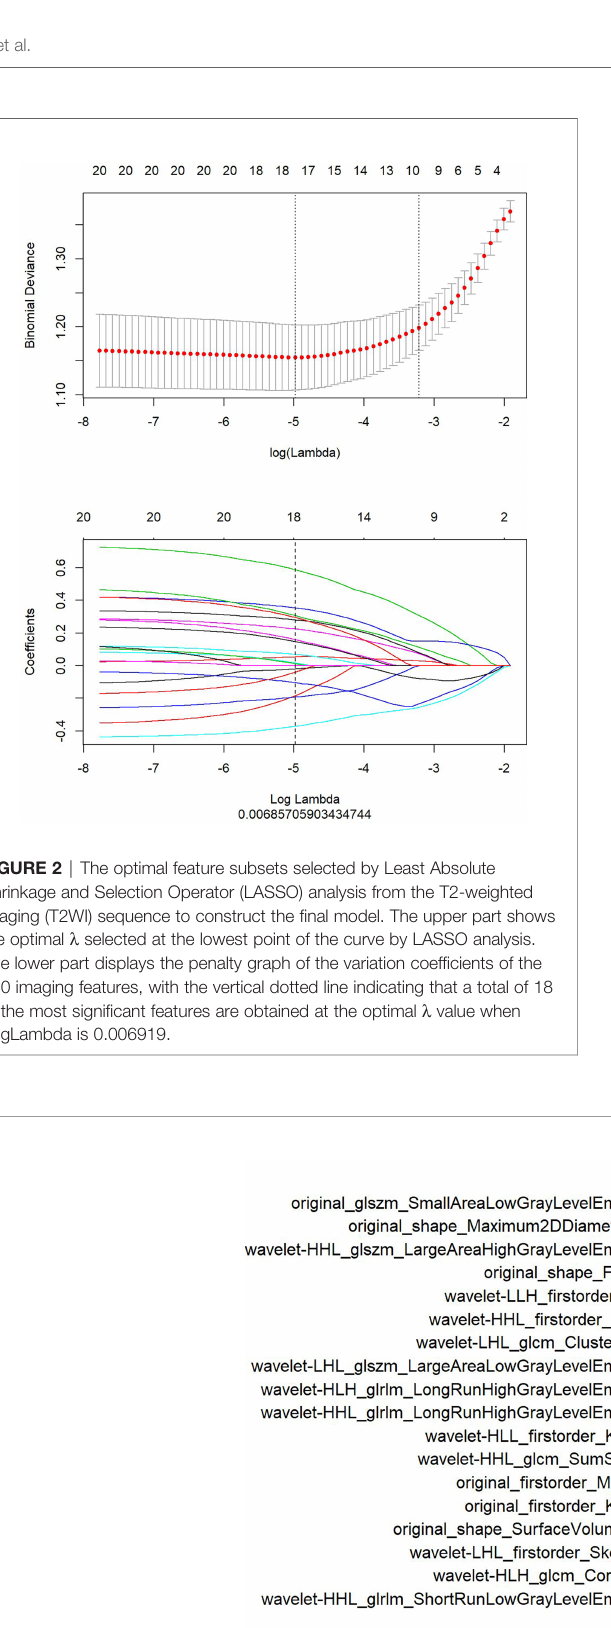
FIGURE 3 | Features selected from the T2-weighted imaging (T2WI) sequence and the corresponding weights. The left part shows the 18 features selected from the T2WI sequence, whereas the right displays the weighting coef fi cients of the corresponding selected features.